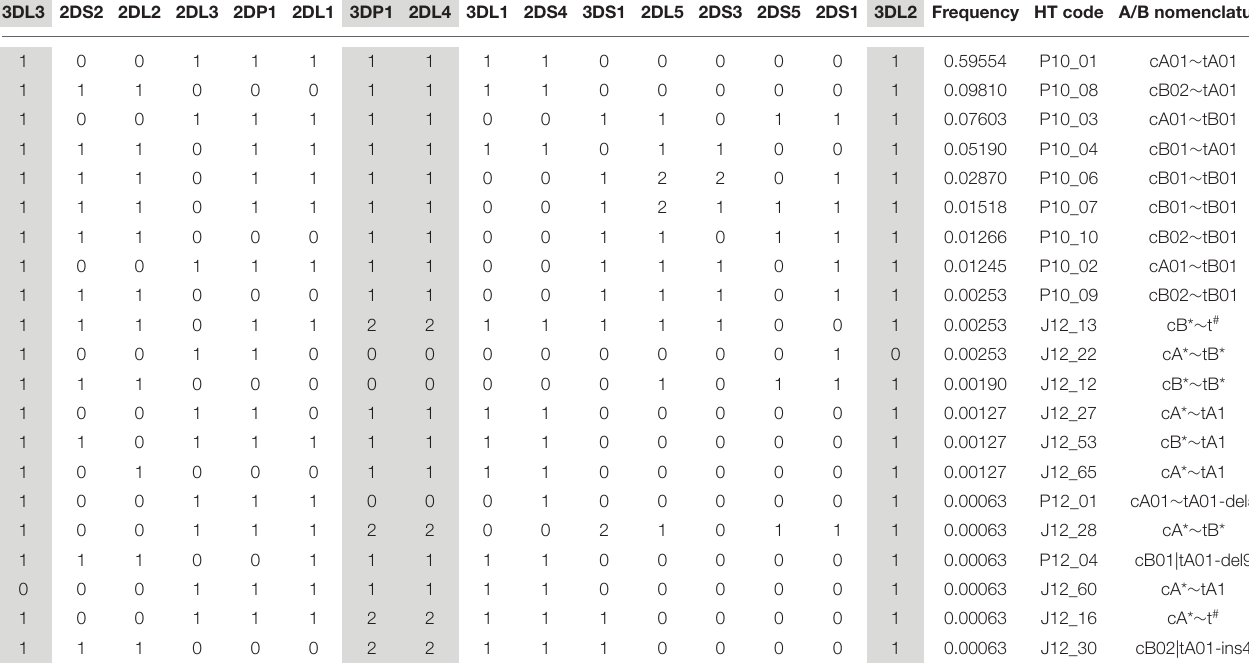
Framework genes are shaded in gray. A/B haplotype nomenclature according to Pyo et al. (48, 50) was added where the assignment was possible. HT code, code of the copy number haplotype pattern; c, centromeric; t, telomeric; ∼ , point of separation between framework genes KIR3DP1 and KIR2DL4; * , affiliation to a general A or B structure but deviation from the established nomenclature; # , distinction between A and B not